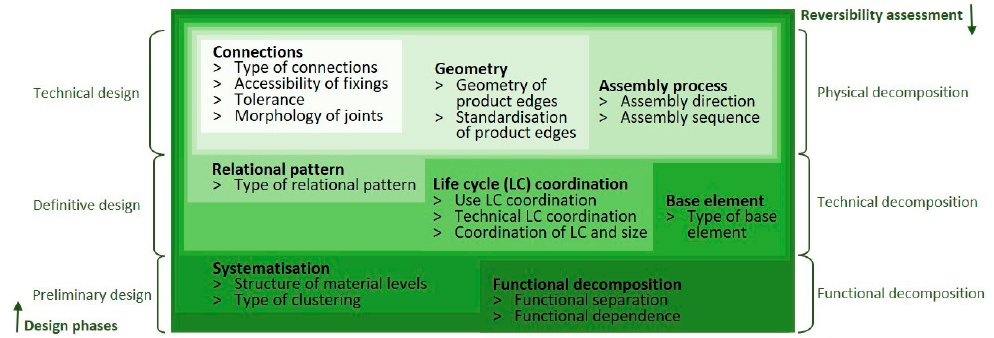
Figure 2. Reversible building design protocol for technical aspects of reversibility (own adaption of [33]), in which the type of connection is the first indicator at the core when applying the design protocol to assess the reversibility of a building.